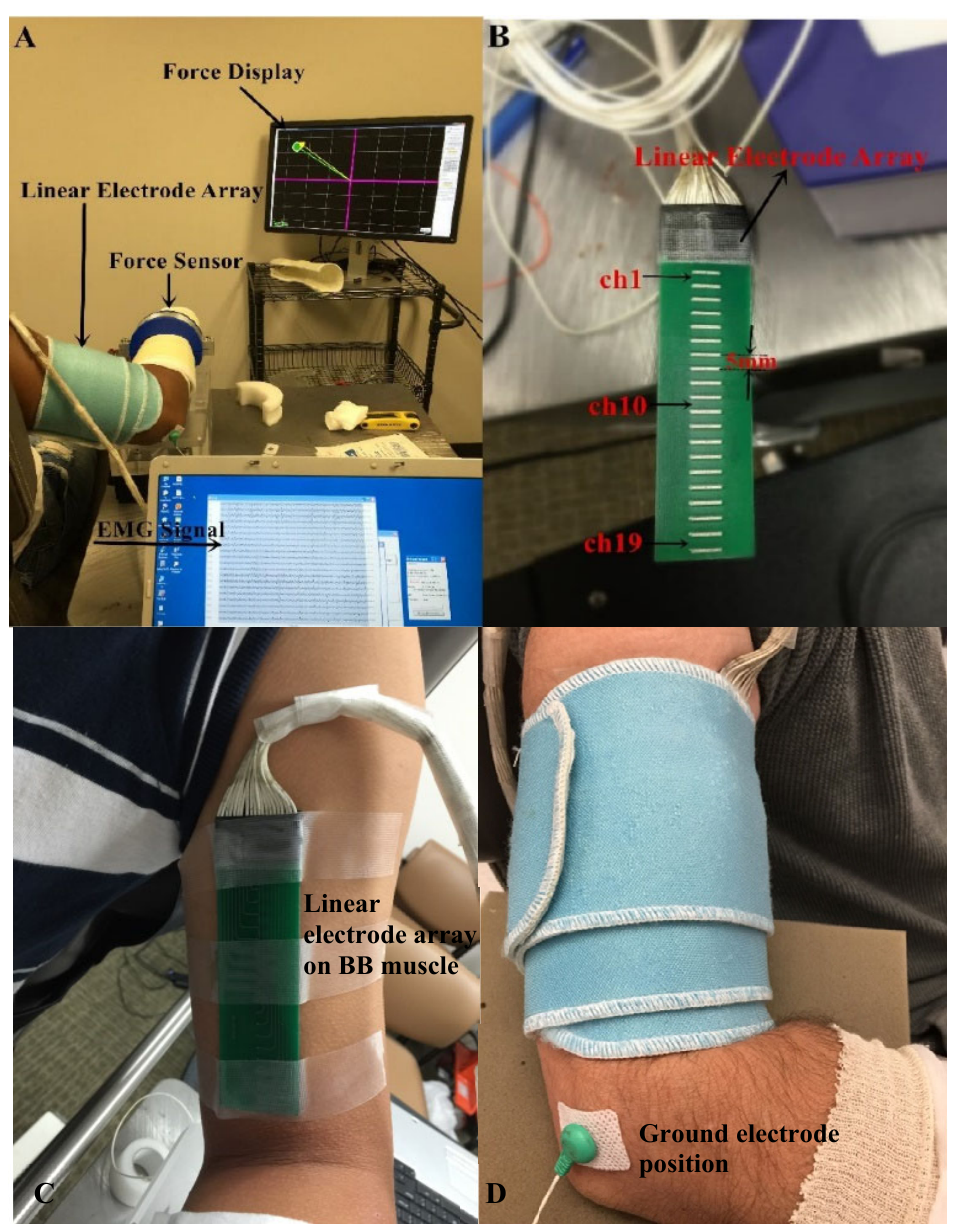
Figure 1. Experimental setup. ( A ) Force display and EMG recording; ( B ) The linear electrode array used for surface EMG recording; ( C ) The placement of the linear electrode array on BB muscle belly; ( D ) The fixation of the linear electrode array.